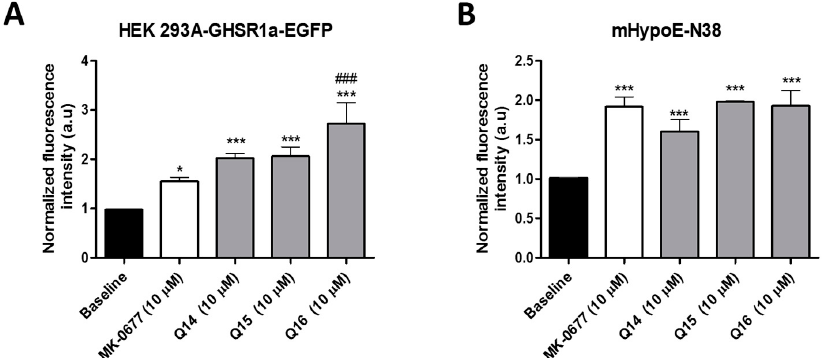
Figure 4. Quinolone compounds activate GHS-R1a receptor overexpressed in Hek cells as well as the endogenous receptor expressed in hypothalamic neurons. Quinolone compounds (10 µ M) and MK-0677 activate GHS-R1a receptors in transfected human embryonic kidney (Hek293a) cells ( A ) and embryonic mouse hypothalamic cell line-N38 ( B ) by using cell calcium imaging through confocal microscopy (for visualization, see Supplementary videos in Supplementary files). Significant differences compared to the baseline and MK-0677 controls are presented with * and # respectively with * indicating p ≤ 0.05